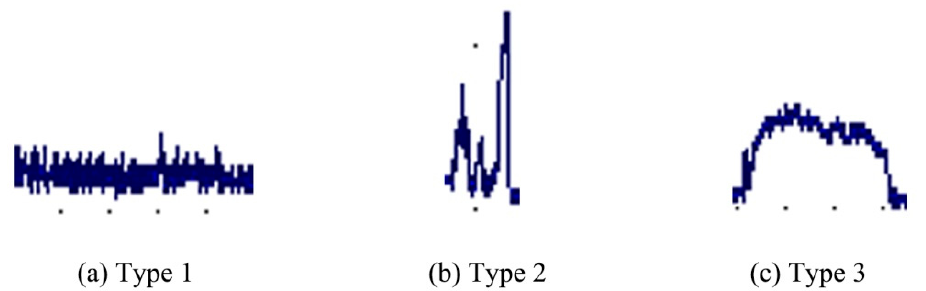
Figure 7. Three different types of discharge current signals in ECDM. ( a ) Type 1 is a current with a small amplitude and a narrow pulse duration, ( b ) type 2 is a high − intensity current with a short pulse duration and ( c ) type 3 is a high − intensity current with a long pulse duration.